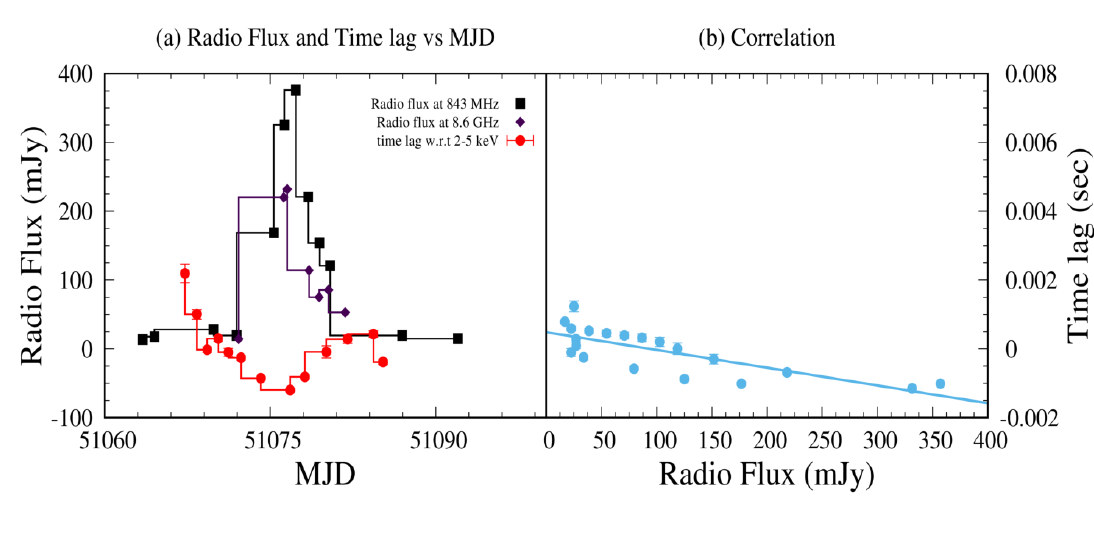
Figure 1. ( a ) Radio flux and X-ray lags are plotted with MJD for XTE J155-564. ( b ) Correlation between radio flux and time lag is plotted for XTE J1550-564. We opted for near simultaneous approach for the radio and time lag data. The fitted slope ( a = − 6.01 × 10 − 6 ) is found to be